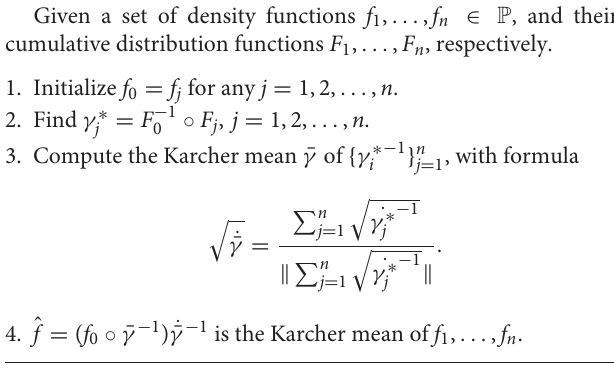
Algorithm 1: Karcher Mean Computation